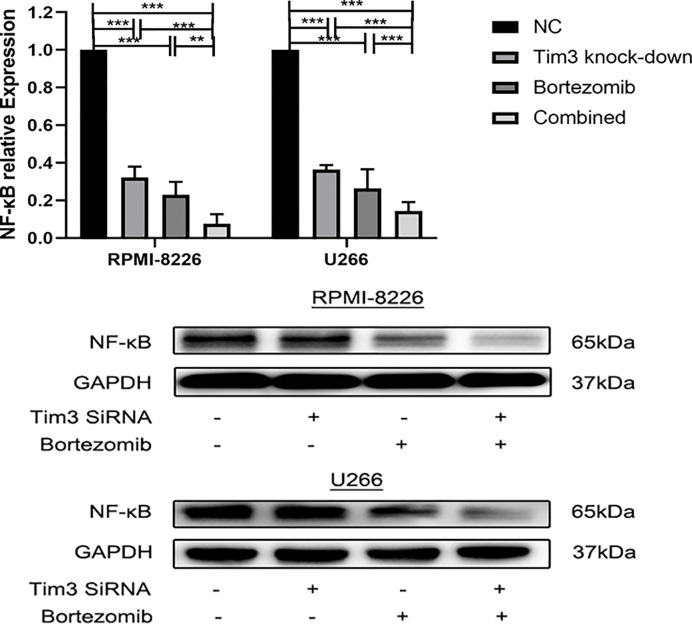
The effects of bortezomib combined with Tim3 knock-down on the relative mRNA and protein expression of NF-κB in RPMI-8226 and U266 cell lines. Shown are average values with standard deviations. Data are performed from 3 independent experiments.** indicated p<0.01, *** indicated p<0.001.